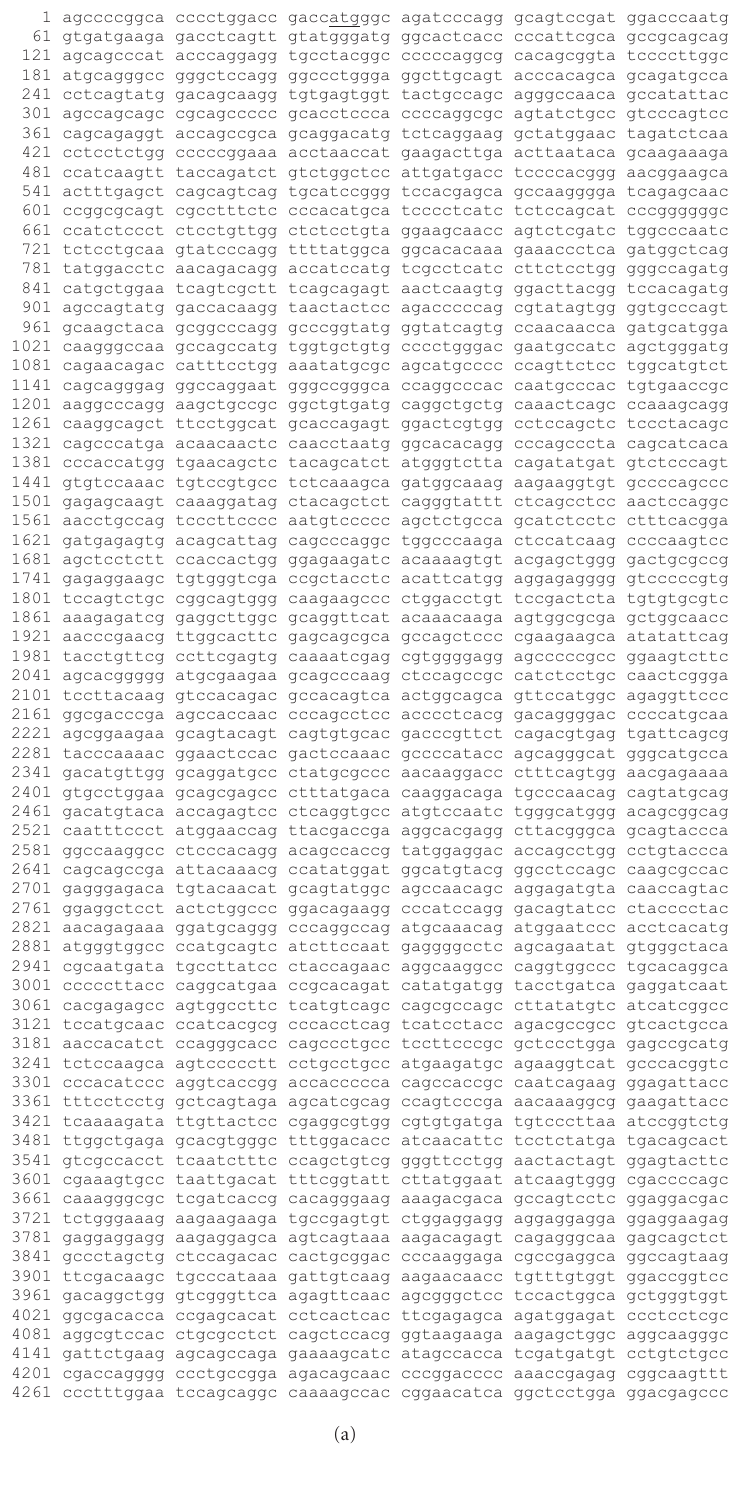
Figure 1: Full-length ORF sequence of rat 6A3-5, 6569 pb . (a) The full-length rat 6A3-5 cDNA has a first methionine that corresponds to an ATG codon (position 25 underlined) and a stop codon (TGA, position 5301) followed by polyadenylation signal (position 6299). (b) ORF translation sequence with 1758 aa. Conserved motifs are indicated: ARID motif (568–672) is underlined, OHD motifs (OHD1: 1114-1200; OHD2: 1437–1758) are boxed, and NLS (nuclear localization signal) (1352–1369) in